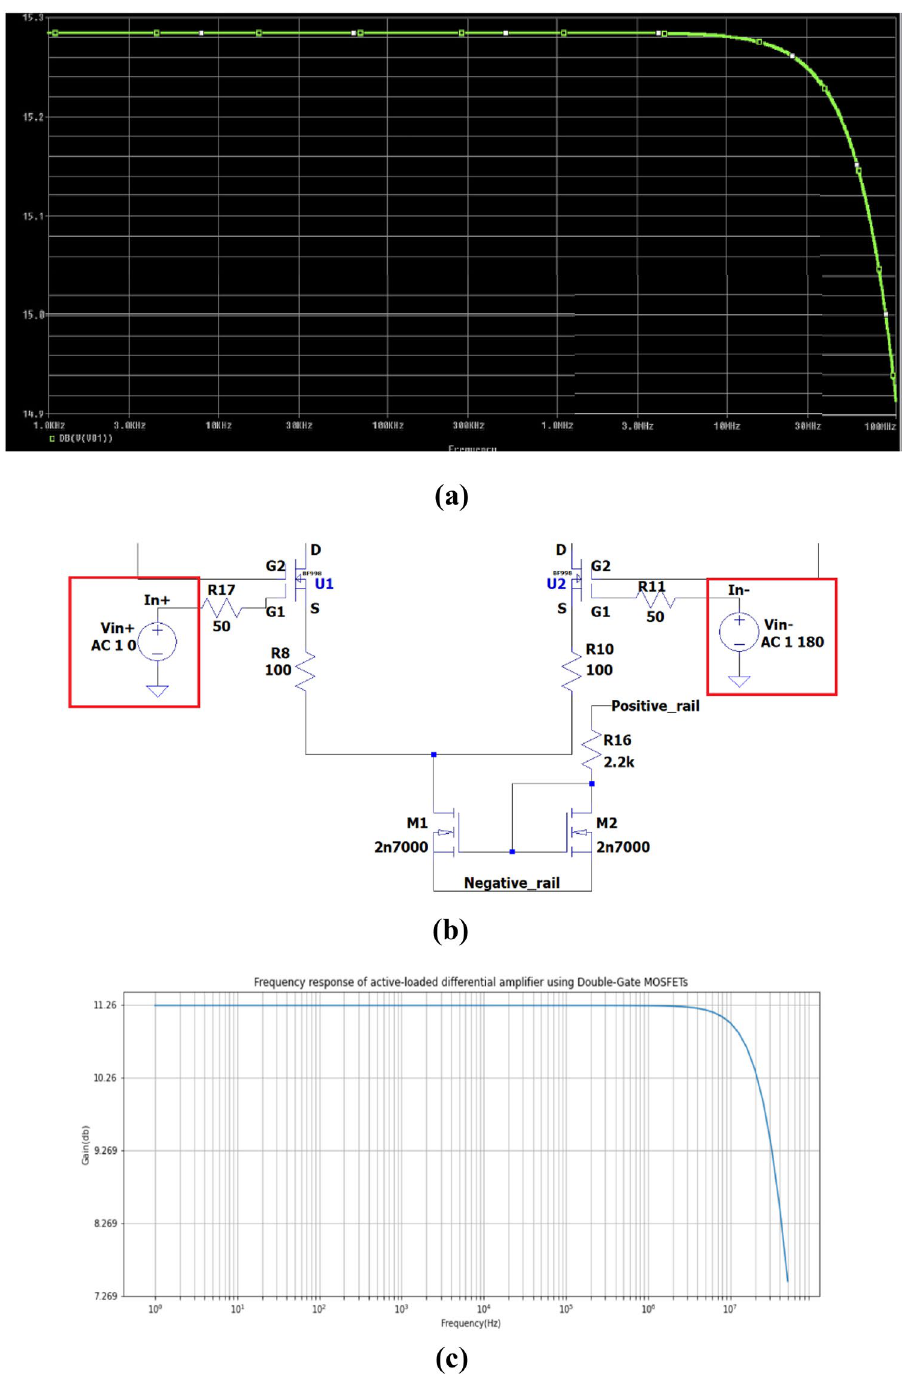
Fig. 11 a Frequency response of differential amplifier using DG MOSFET [13]. b Test setup for deriving frequency response of the differential amplifier. c The frequency response of the proposed amplifier exhibits a bandwidth of 42 MHz and a mid-band gain of 11.25